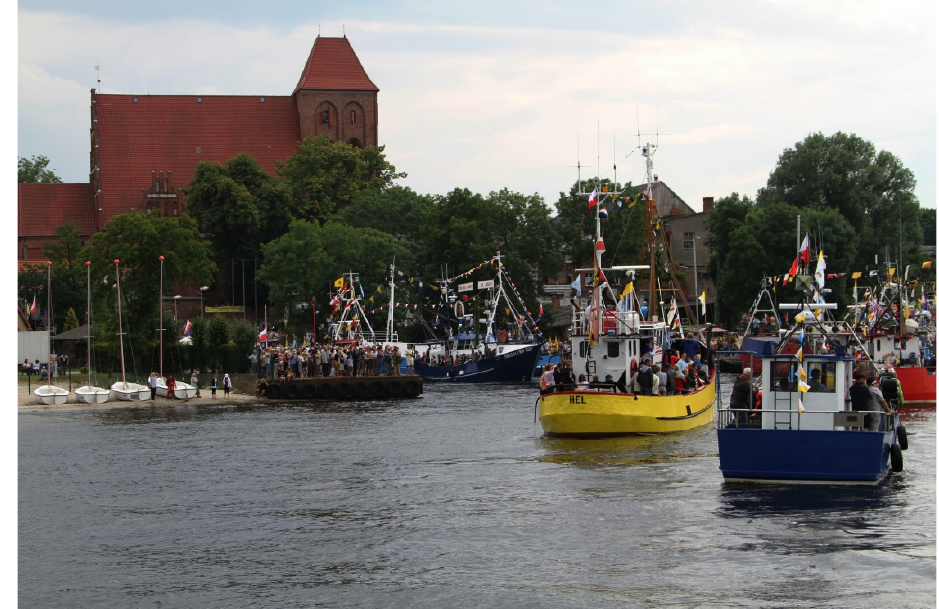
Figure 5. Fishing boats docking at the port in Puck. Author: (Tadeusz Palmowski 2013).